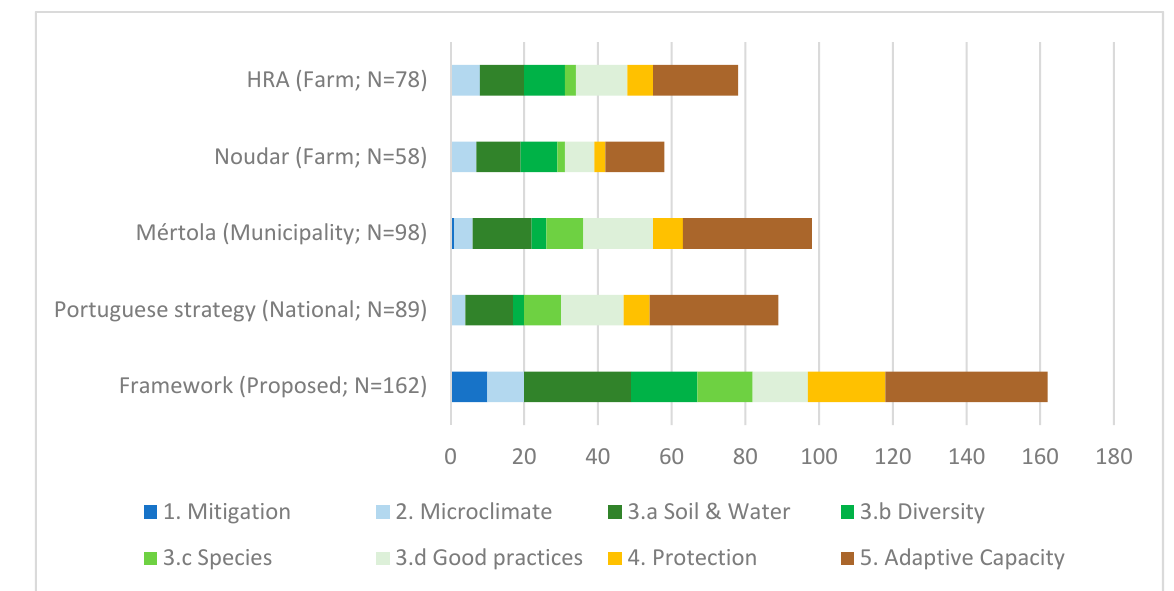
Figure 4. Number of adaptation measures per adaptation strategy (detailed level) identified in the adaptation plans of the three case studies, plus the Portuguese National Adaptation Strategy in comparison to the proposed Framework.